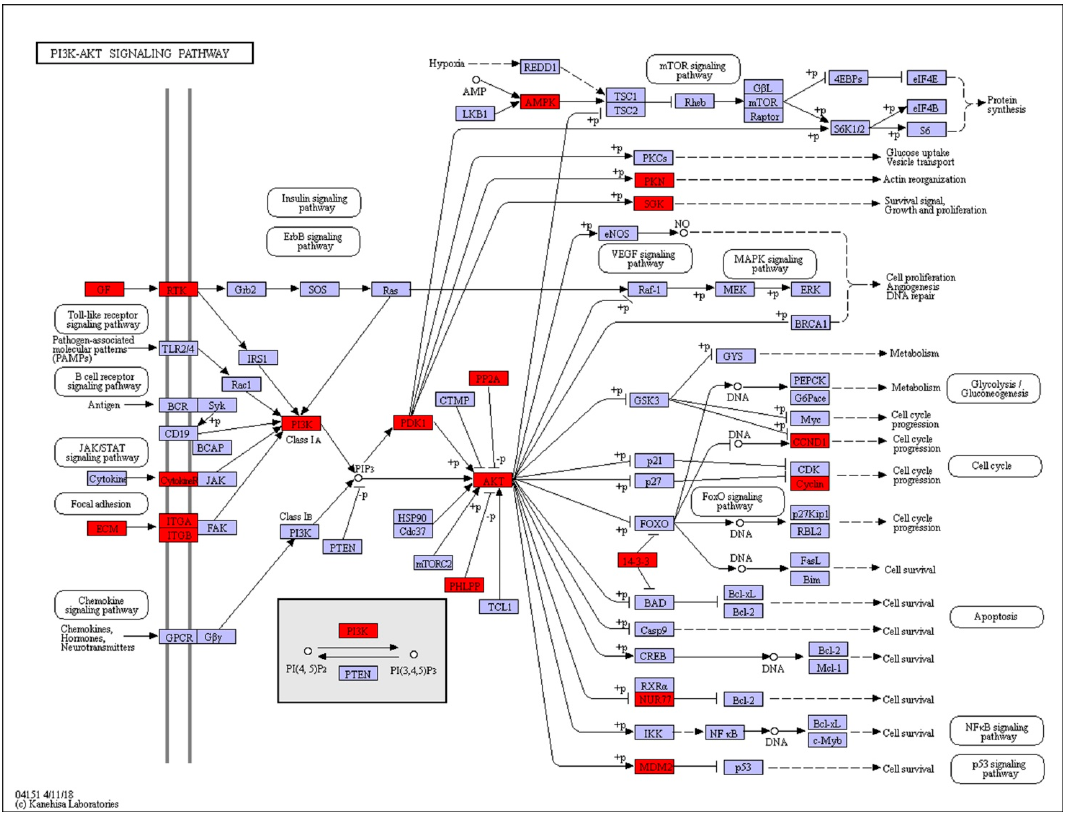
Figure 1. Model of activation of the PI3K/AKT signalling pathway in mink uteri in activated versus diapause states. Differentially expressed genes are shown in red color. Genes in blue boxes were present in the mink transcriptome but not differentially expressed.